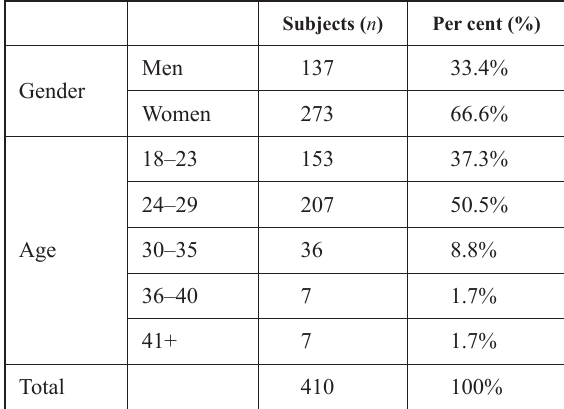
Table. The demographic characteristics of the